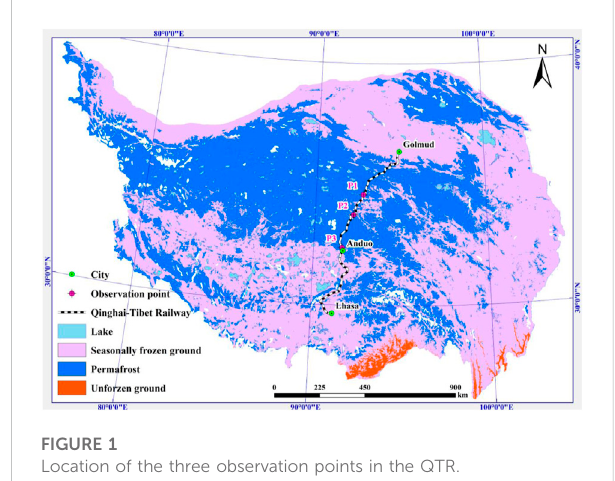
Location of the three observation points in the